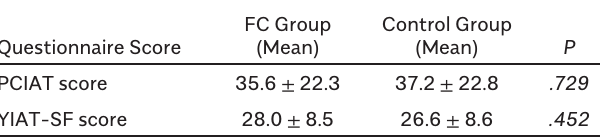
Table 2. The Mean Scores of the Questionnaires